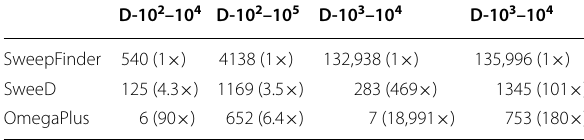
Table 2 Comparison of execution times (in seconds) for different dataset sizes (Fomat: D-number of sequences- number of SNPs) on a single processing core